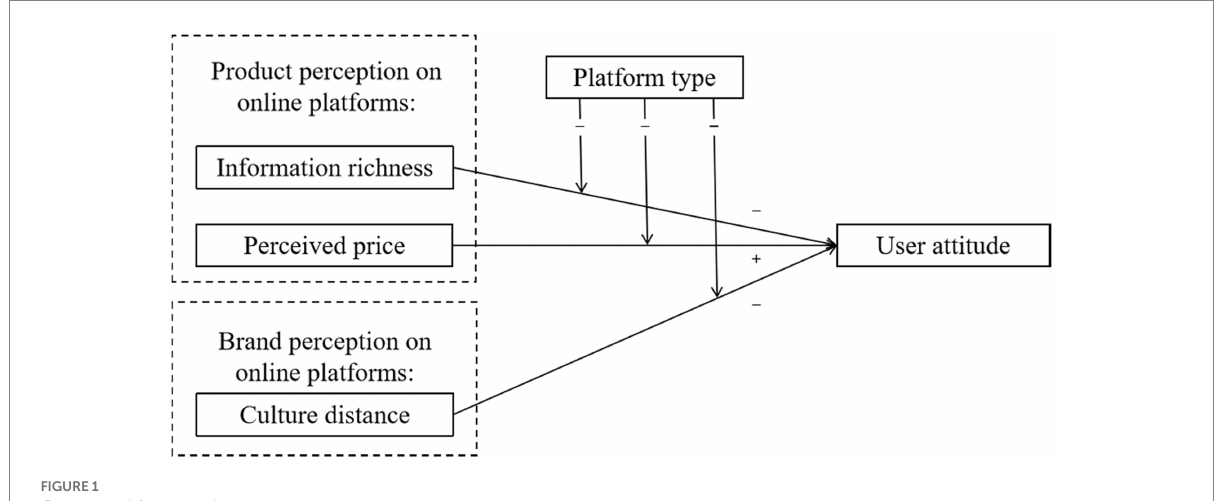
FIGURE 1 Conceptual framework.